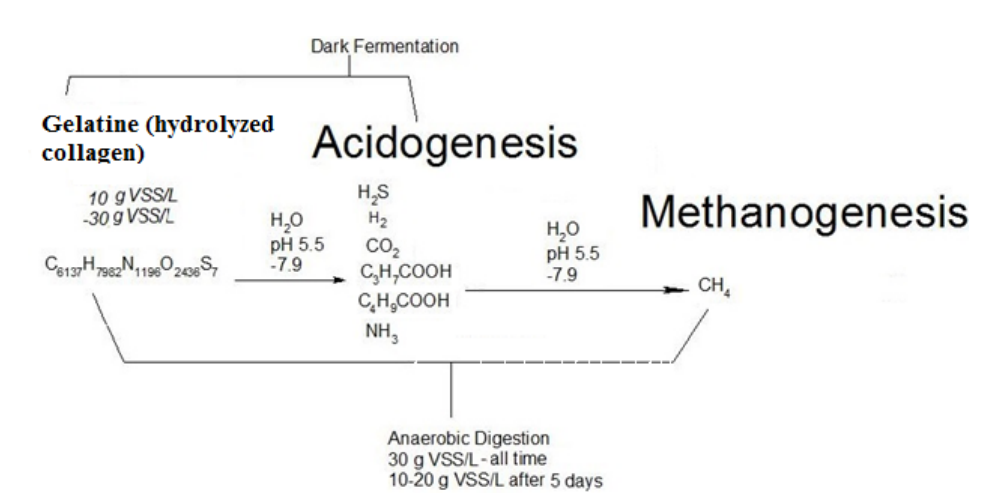
Figure 2. Potential pathways of collagen digestion by DF and AD.